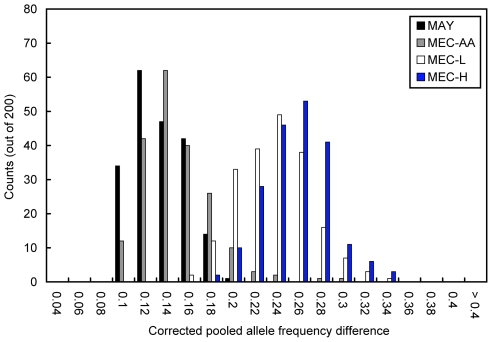
Distribution of allele frequency differences among the top 200 AIMs.The distribution of the corrected allele frequency differences between the estimated pooled allele frequency and that expected based on each population's respective pseudopopulation among the top 200 putative AIMs is shown for the MEC-AA, MEC-H, and MEC-L pools. Corrected pooled AF difference was calculated by fixing the AF in the pseudopopulation, computing the pooled AF in the appropriate direction given the deflated χ2 statistic, and then taking the difference. The distribution observed in the MAY pool represents the null distribution in which few additional validated AIMs are expected. To provide an estimate of the expected AF difference in a scenario where only sampling variation is responsible for the allele frequency difference between a population and its pseudopopulation, we simulated genotypes at ∼382 K SNPs for 521 individuals (the same number of post-QC SNPs and individuals as used in the MAY pools), drawing from the allele frequency in YRI 82% of the time and CEU 18% of the time, and compared the allele frequency of the simulated genotypes to that expected based on a 82%–18% mix of YRI and CEU. From this comparison, the top “AIMs” would only have an allele frequency difference of < ∼0.08.